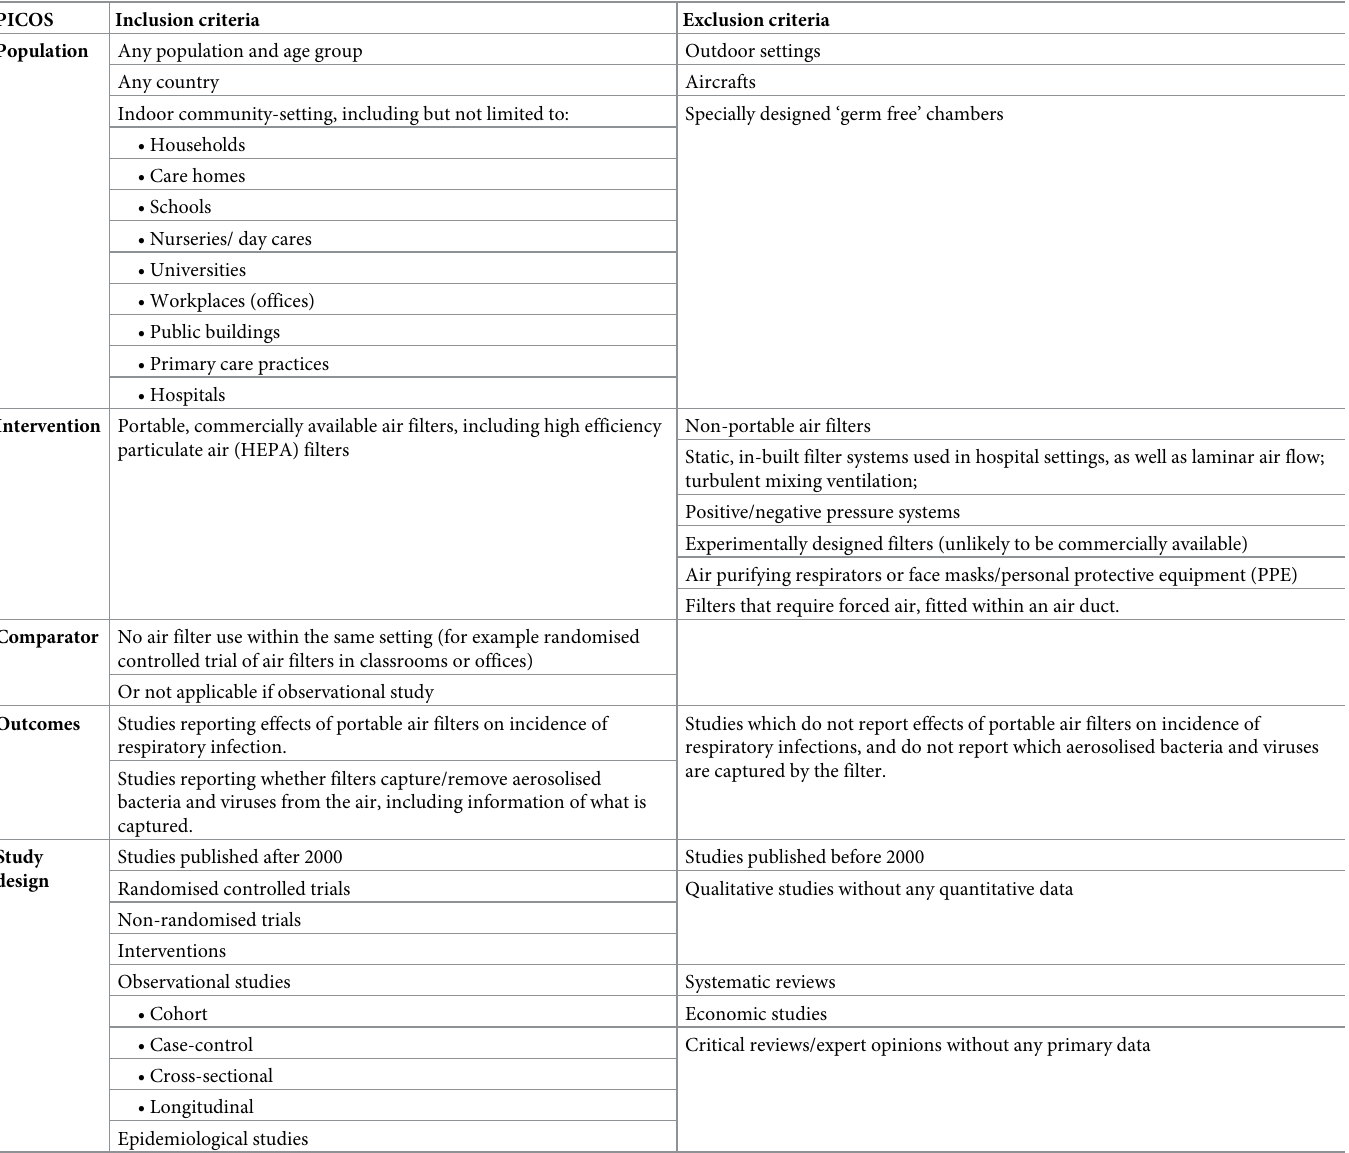
Table 2. Population, intervention, comparator, outcome and study design criteria for inclusion and exclusion. PICOS Inclusion